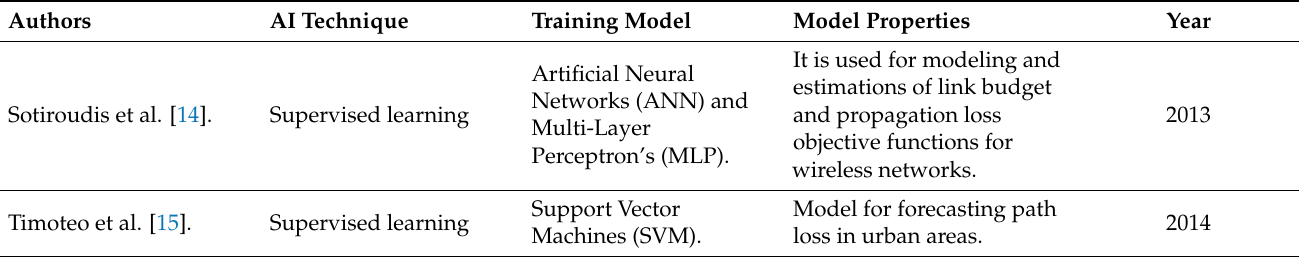
Table 2. A comparison between AI